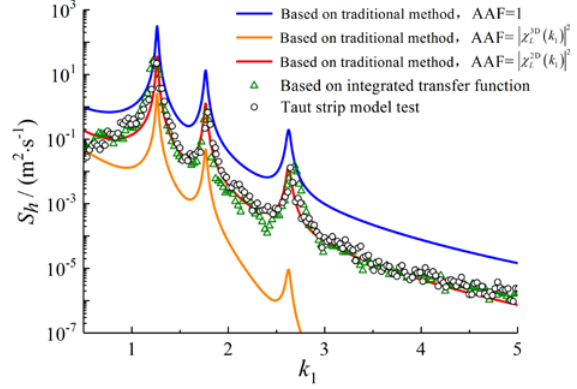
Figure 19. Buffeting response prediction results.